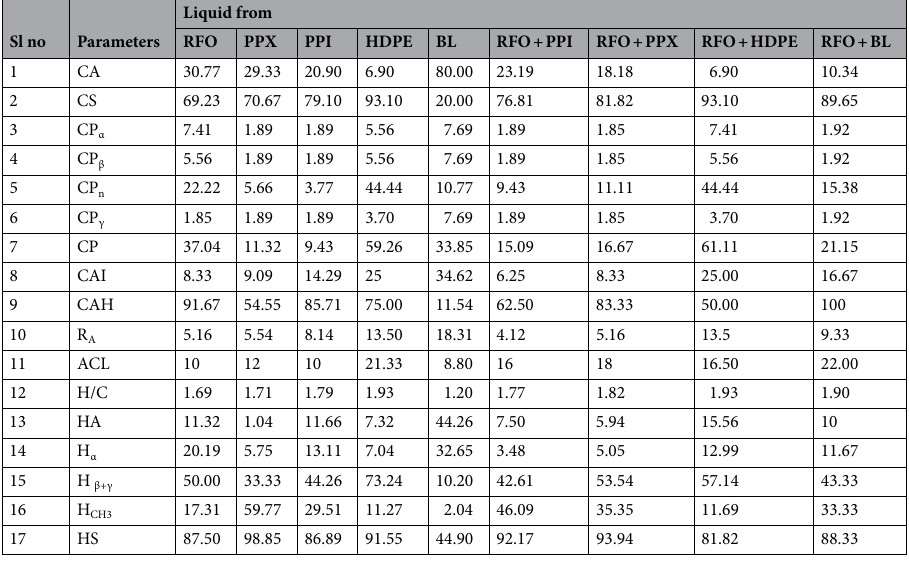
Table 4. Average structural parameters (Derived from 1 H and 13 C NMR data) of liquid products obtained from co-cracking of RFO with various types of